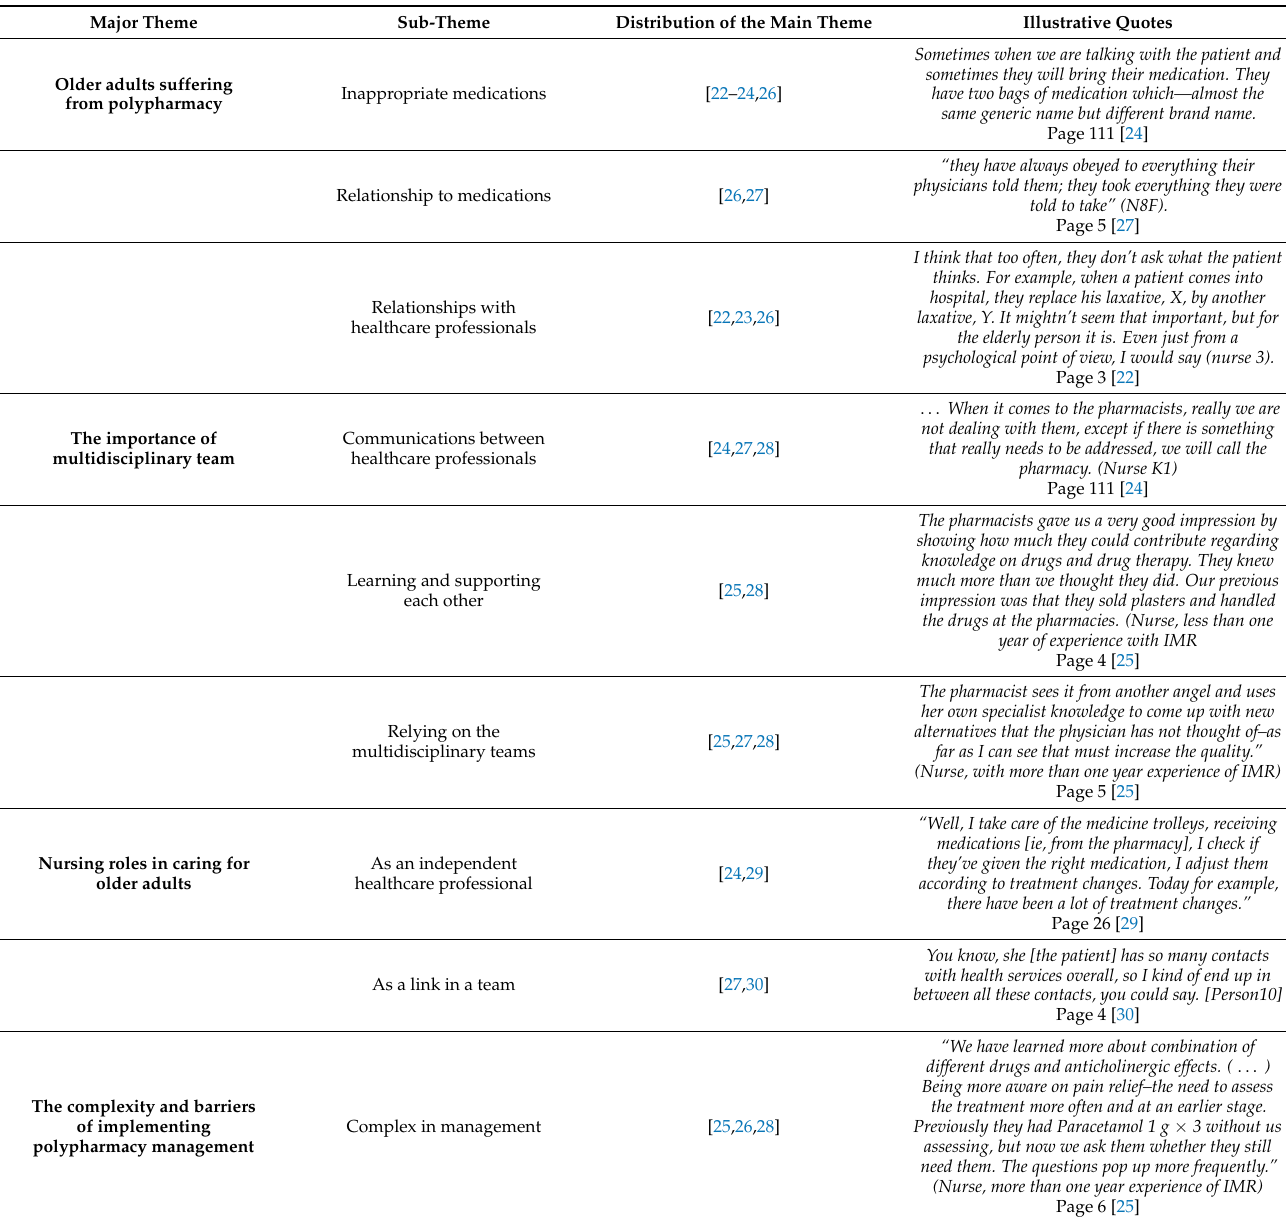
Table 3. An overview of the major theme, sub-theme, and illustrative